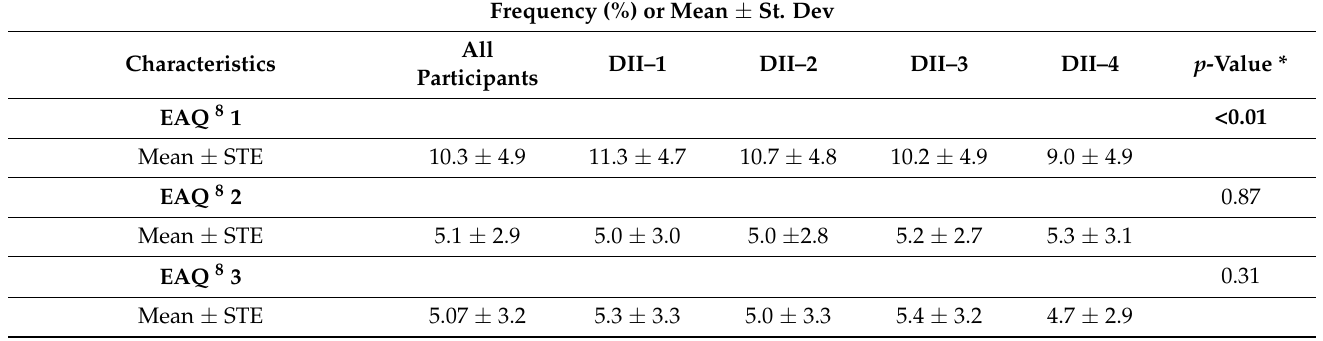
Table 1. Cont. Frequency (%) or Mean ± St.